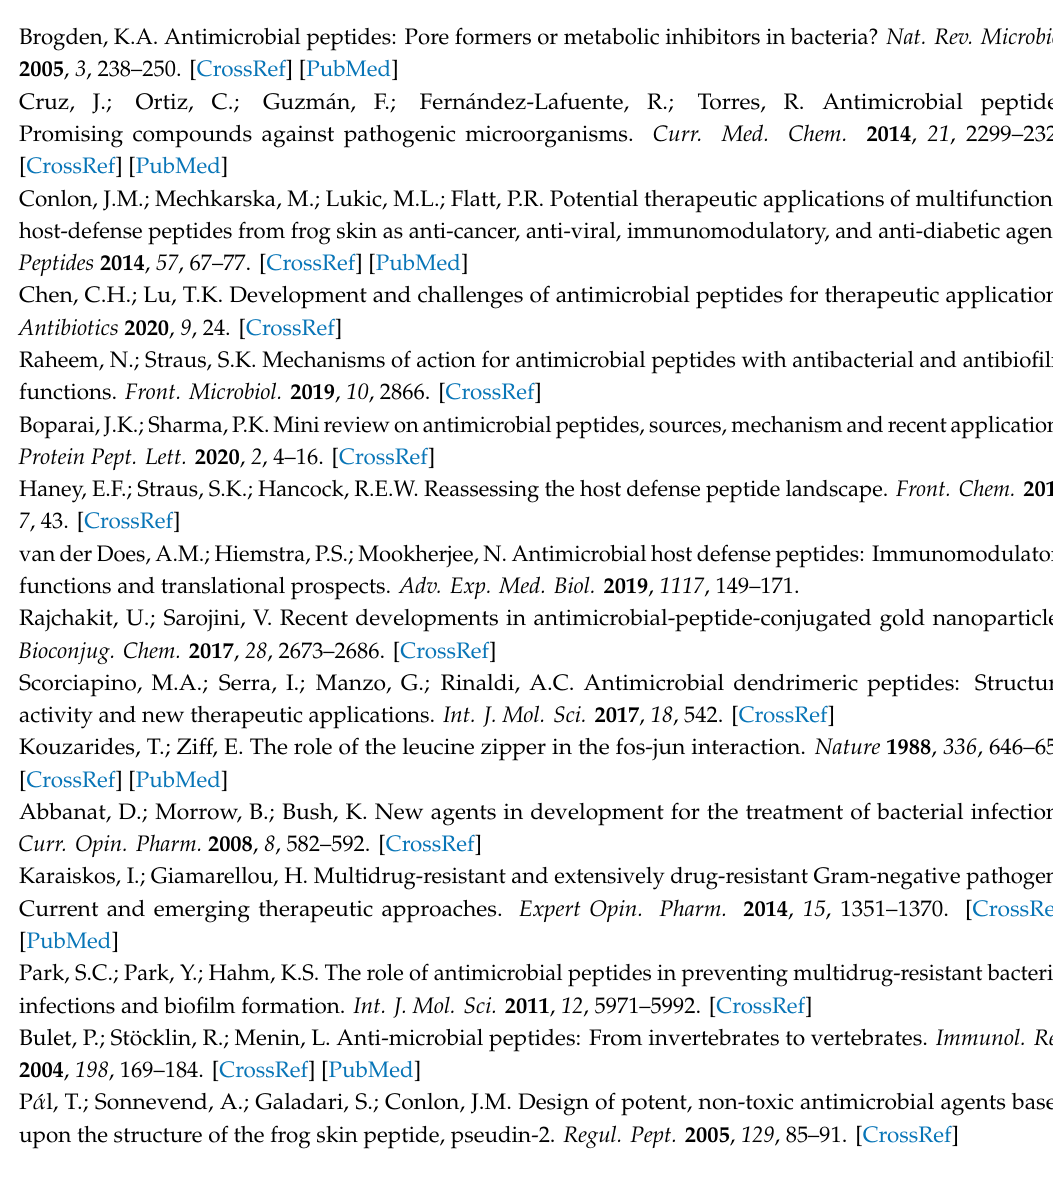
Figure S1: Mass data of pseudin-2, Figure S2: Mass data of P2-LZ1, Figure S3: Mass data of P2-LZ2, Figure S4: Mass data of P2-LZ3, Figure S5: Mass data of P2-LZ4, Figure S6: P2-LZ5, Figure S7: HPLC profile of pseudin-2, Figure S8: HPLC profile of P2-LZ1, Figure S9: HPLC profile of P2-LZ2, Figure S10: HPLC profile of P2-LZ3, Figure S11: HPLC profile of P2-LZ4, Figure S12: HPLC profile of P2-LZ5, Figure S13: CD spectra of peptides in 10 mM sodium phosphate bu ff er (pH